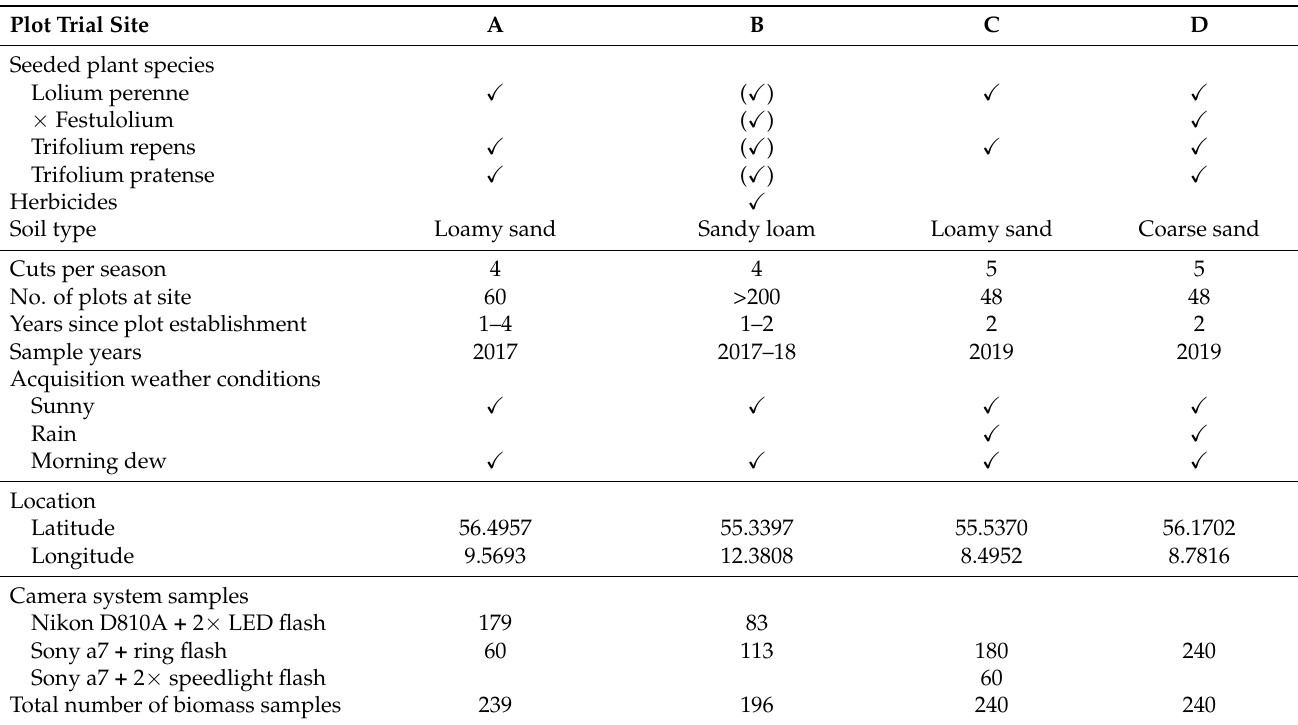
Table 1. Comparison of the four plot trial sites. Plots in site A, C, and D were all established with a location-specific seed mixture, followed by nitrogen application trials to induce a varied clover content across the plots. Plots in site B were established with a wide range of commercially available seed mixtures, leading to a high variation between the plots, but inconsistent representation of the four species in the